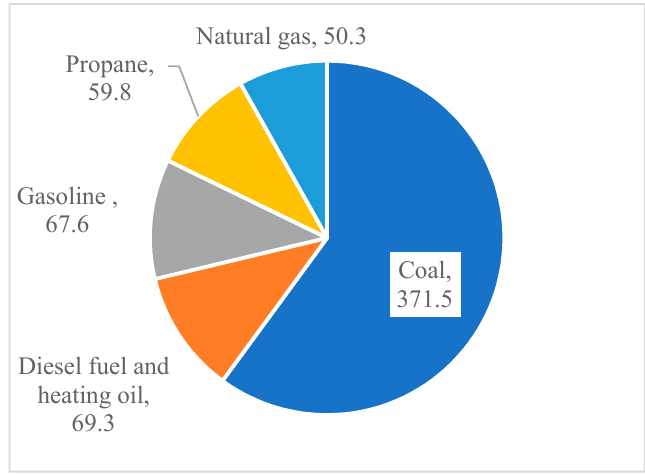
Figure 1. kg of CO2 emitted per million kJ of energy for various fuels in 2020 [2].